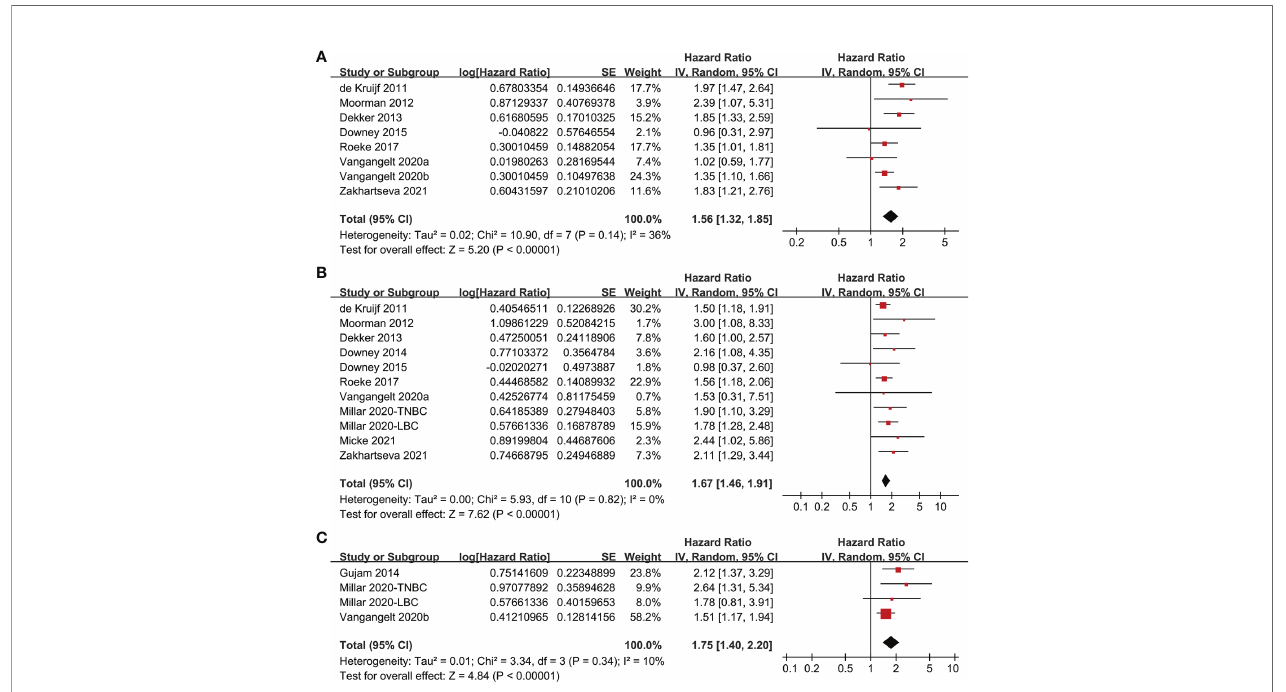
FIGURE 2 | Forest plots for the meta-analysis of the association between TSR and survival in women with breast cancer; (A) , association between TSR and DFS in women with breast cancer; (B) , association between TSR and OS in women with breast cancer; and (C) , association between TSR and CSS in women with breast cancer.